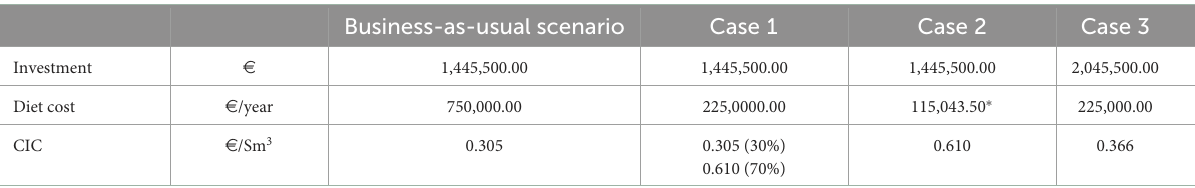
TABLE 3 Main characteristics of each hypothetic scenario.